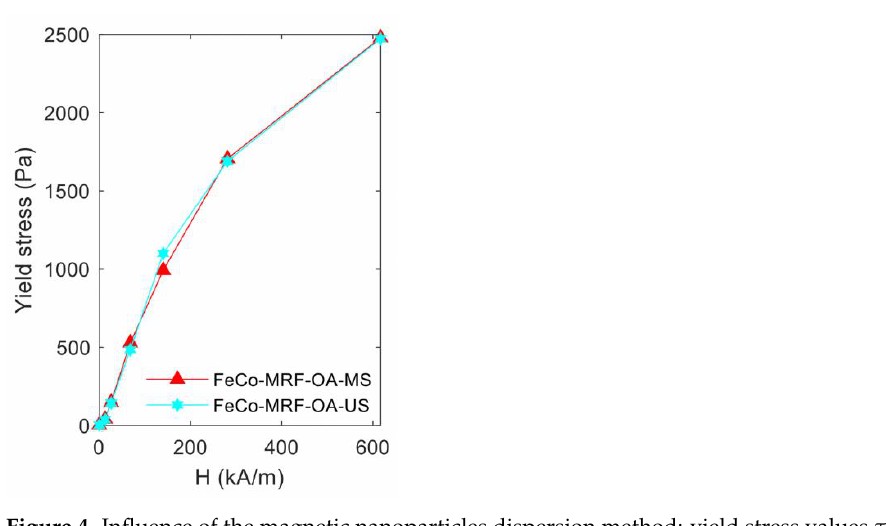
Figure 4. Influence of the magnetic nanoparticles dispersion method: yield stress values τ 0 obtained from the fit to the Herschel-Bulkley expression, for the different applied magnetic field intensities. Table 4. Values of the stress measured at the maximum shear rate (600 s − 1 ) under different applied magnetic field conditions, for the two different magnetic filler dispersion